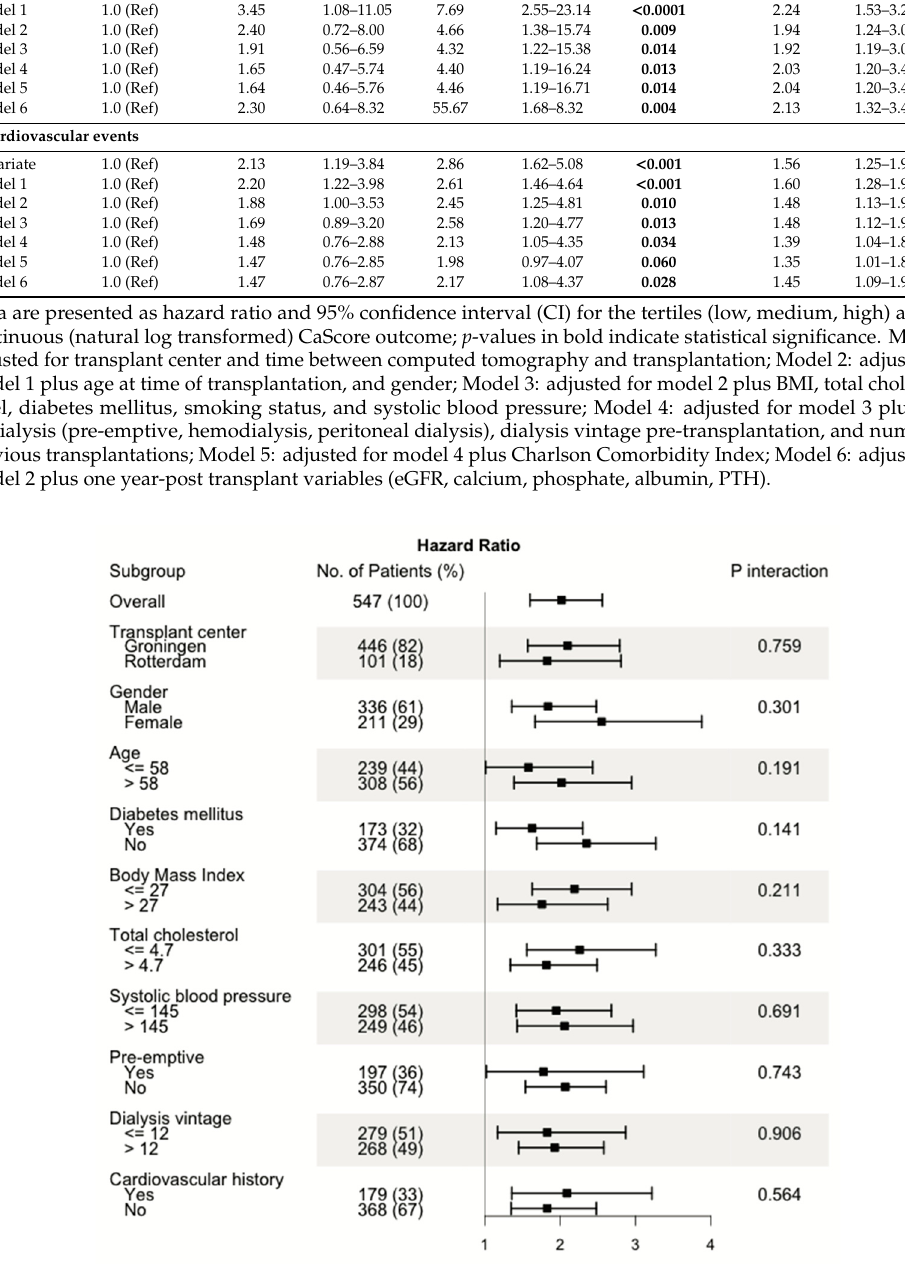
Figure 3. Forest plot of hazard ratios for the univariable subgroup analysis and p -values of interaction analysis for aorto-iliac calcium score (CaScore) (continuous) and all-cause mortality.